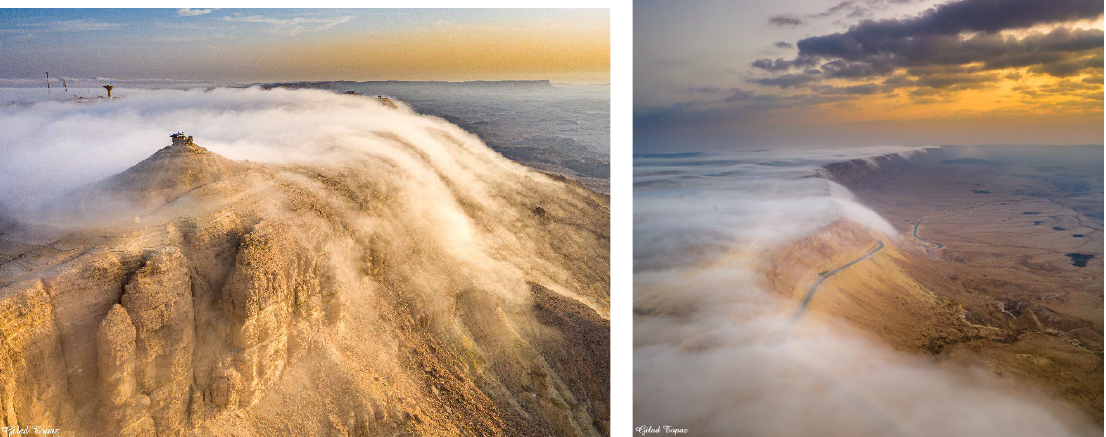
Figure 1. Images of radiation fog near the city Mitzpe Ramon in the Negev Highland Desert, Israel. The fog dissipates as it is carried down the cliffs of the Ramon Crater. Two cases depict the beauty of this phenomenon: ( left ) 11 October 2019 ( right ) 20 November 2020. Courtesy of Gilad Topaz (https://www.instagram.com/giladdrone/, accessed on 11 September 2022).